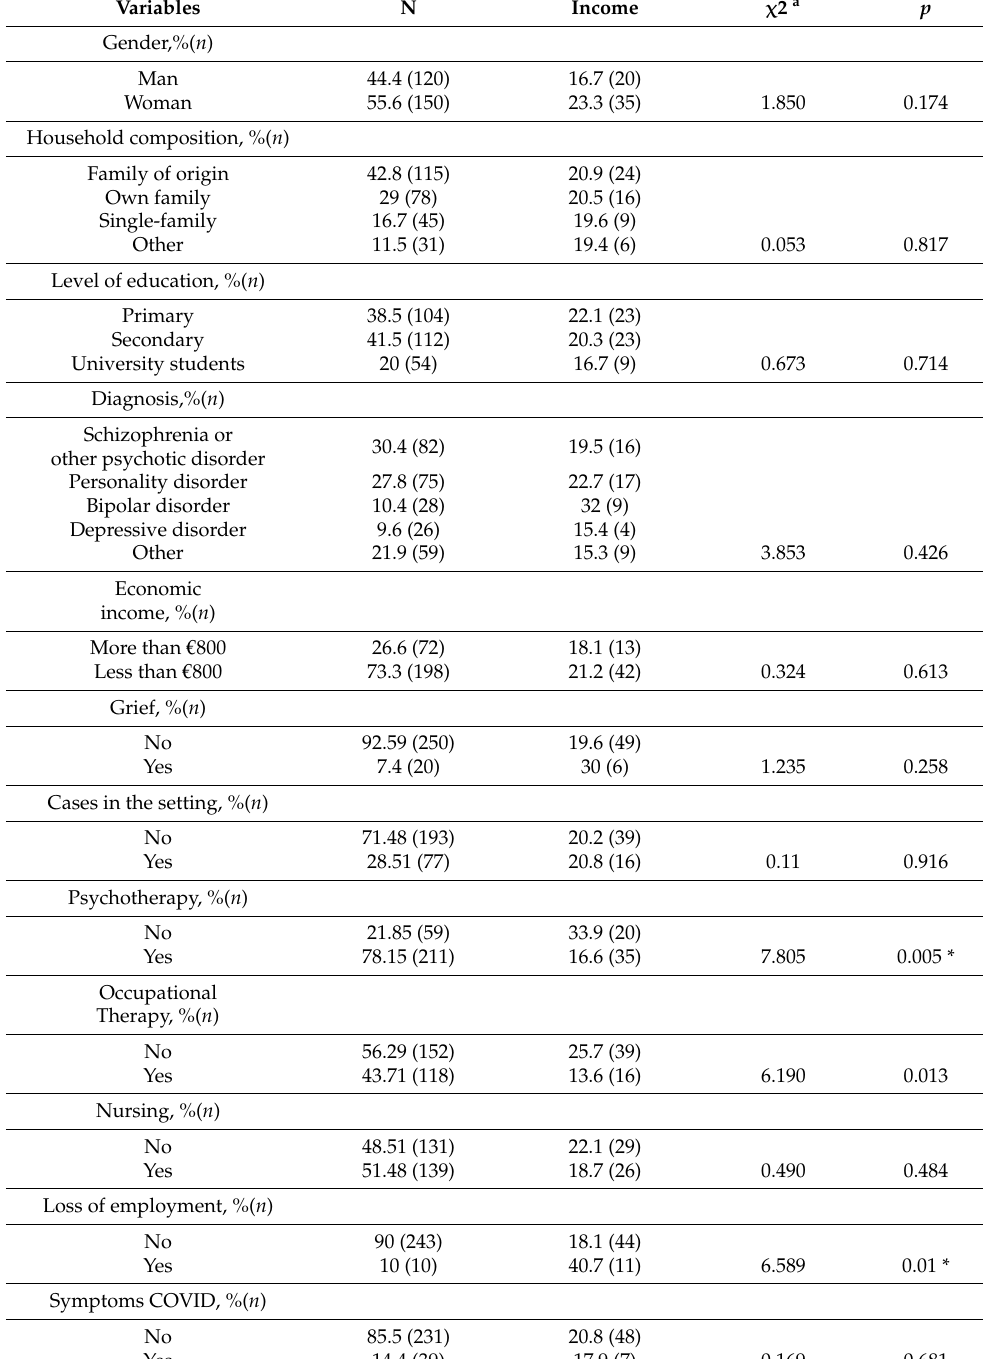
Table 1. Bivariate analysis of the proportion of full mental health inpatient admissions as a function of different